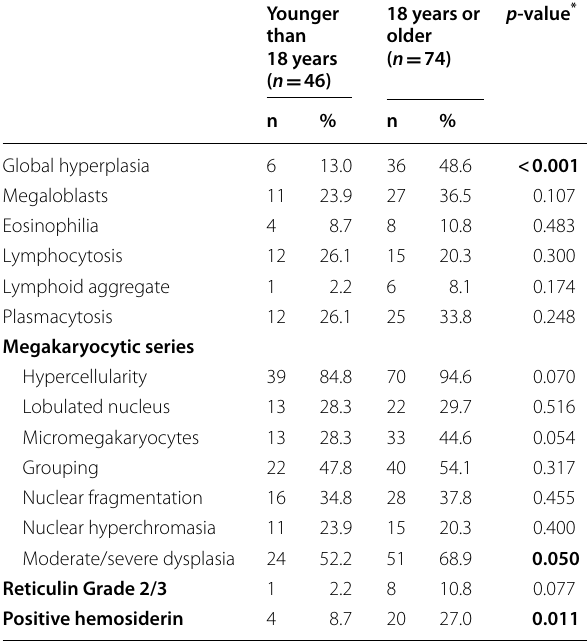
Table 3 Association between BM morphological parameters and age group in 120 patients with